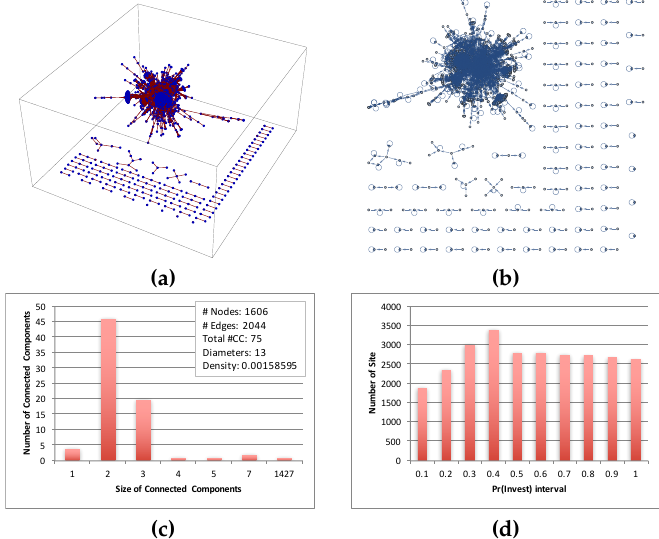
Figure 9. The Structure of an Attack to the Internet. The 3-d graph ( a ) corresponds to the top 402 Internet autonomous systems (AS)-level nodes most likely to be attacked according to our model at 0.005-MSNE, and their neighbors (i.e., both parent and children family). Graph ( b ) is a 2-d projection of the 3-d graph ( a ). The self-loops mark the nodes that are actually attacked. For the most part, the graph structures exhibit very dense clustering. Bar graph ( c ) corresponds to the number of connected components ( CCs ) of the top 402 Internet AS-level nodes that are most likely to be attacked. Bar graph ( d ) shows the number of nodes with the probability of investing in defense/security measures within the range of ([ 0,0.1 ] , ( 0.1,0.2 ] ,..., ( 0.9,1 ]) . Some properties of the graph corresponding to the network structure are shown on the upper corner of graph ( c ). The graph consists of 1606 nodes, 2044 edges, and 75 CCs. Out of the 75 CCs, the largest CC contains 1427 nodes and the smallest CC consists of just 1 node (there are only 4 of them). There are 46 of 2-CC (CC with only 2 nodes), 20 of 3-CC, 1 of 4-CC, 1 of 5-CC, and 2 of 7-CC. The diameters and density of the graphs are 13 and 0.002,